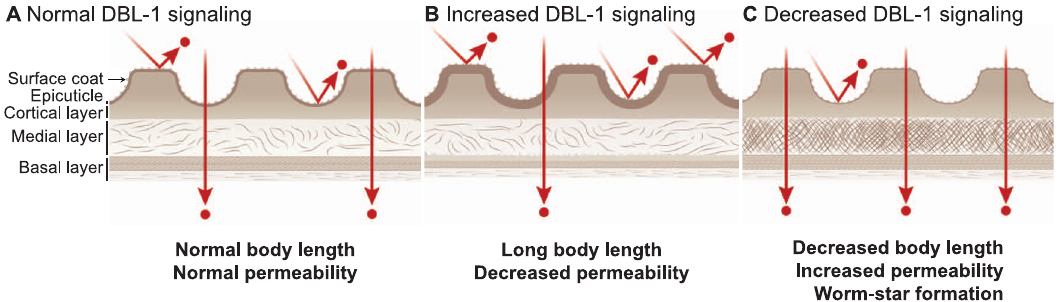
Figure 6. Model of DBL-1 pathway-mediated cuticular phenotypes. Model of how DBL-1 controls organization and composition of the cuticle, which affects body length, permeability barrier function, and worm-star formation in animals with normal (A), increased (B), and decreased (C) DBL-1 pathway signaling. Cuticle layers are indicated on the left.